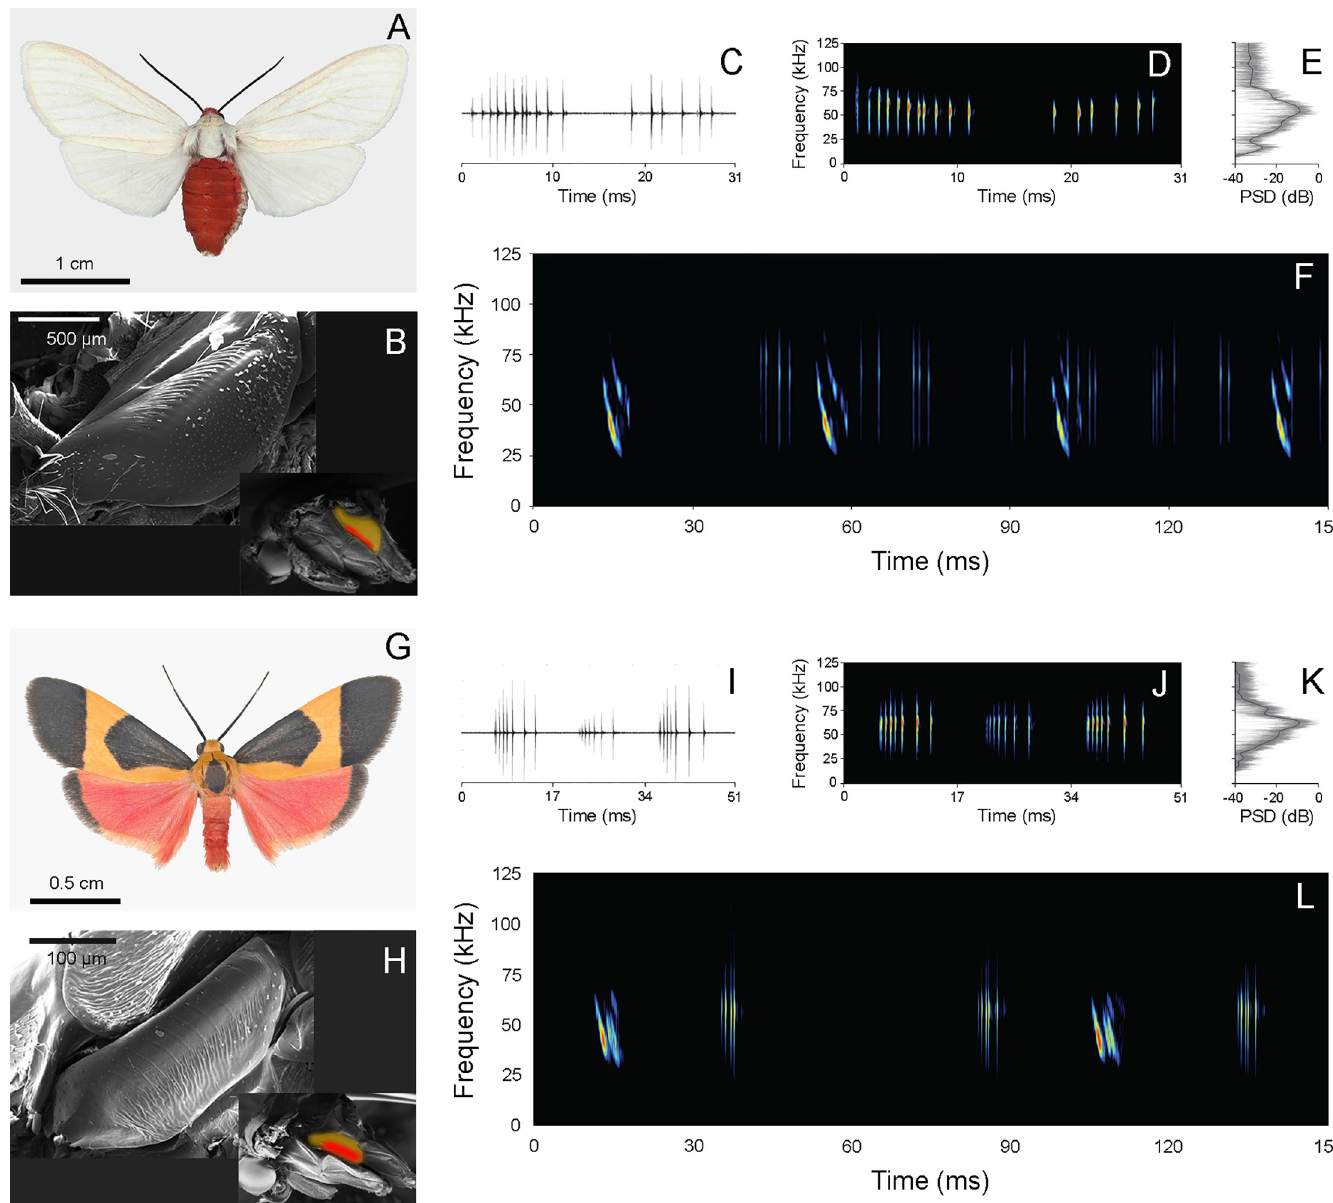
Fig 1. Morphology and acoustic emissions of Pygarctia roseicapitis (A-F) and Cisthene martini (G-L). The moths ( A, G ) and their corresponding tymbal organs ( B, H ), oscillogram ( C, I ), spectrogram ( D, J ), power spectral density plot ( E, K ), and the spectrogram of their response to simulated bat cries ( F, L ) are shown. Tymbal images are oriented with anterior on the left and ventral on the top with some scales removed. Insets show the relative position, orientation, and size of the tymbal (yellow) organ and microtymbals (red) on the thorax of each species. Insets are oriented with anterior on the left and dorsal on the top. Oscillogram, spectrogram, and power spectral density plots ( C-E, I-K ) show a single activation and relaxation (modulation cycle) of the tymbal organ. Moth responses to simulated bat cries ( F, L ) show each species ’ earliest response and do not correspond to the same segment of time. Bat cries are brightest and sweep from higher to lower frequencies within a single call. Moth clicks are broadband and cluster in groups of clicks. tymbaled group (p = 1). The relative risk of capture between sham-operated and ablated indi- viduals was significant (Fisher ’ s exact test: p = 0.02, odds ratio = 9.44, 95% CI = [1.5, 78.3]). The relative risk of capture for tymbaled C . martini was 1.6 times less than their ablated counterparts (Fisher ’ s exact test: p = 0.03, odds ratio = 11.32, 95% CI = [1.4, 527.6]). Bats did